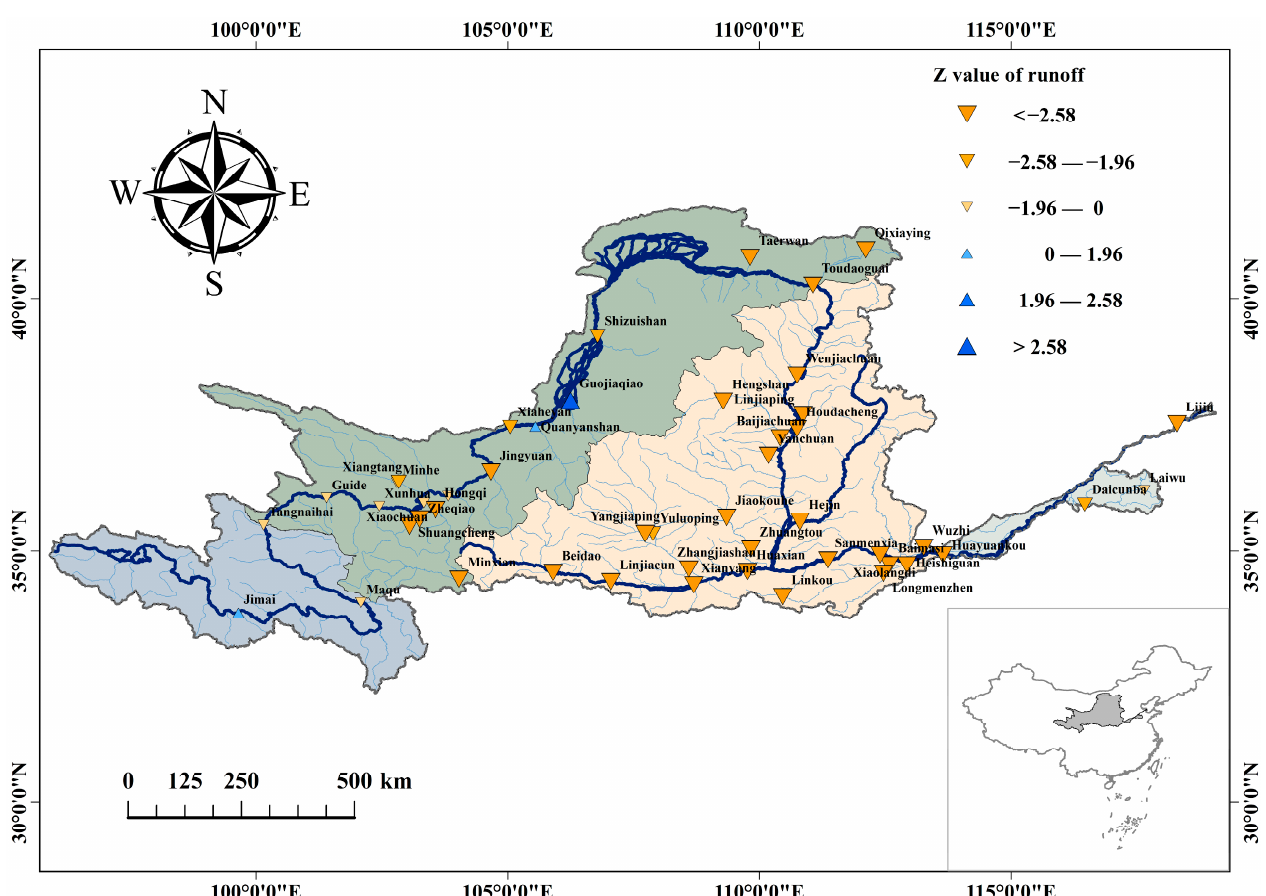
Figure 2. Interannual variation trend of runoff from the main control sections of the Yellow River Basin. The temporal and spatial changes of dry season runoff and its possible ecological influence were further analyzed considering the important impact of low flow on river ecology. Based on the natural hydrological characteristics of the Yellow River Basin, the measured runoff from December to March of the next year was selected as the runoff of the Yellow River Basin during the dry season. The results are shown in Table 3 and Figure 3. It can be seen that the runoff during the dry season in the upper reaches of the Yellow River has a significant increase, especially in the main stream sections. The eight main stream sections in the upstream, with the exception of Maqu, increased significantly in the dry season runoff. This may be caused by two aspects, one being the intensification of glacial meltwater, the other the regulatory influence of the reservoirs. However, the dry season runoff in the middle and lower reaches (below Toudaoguai) exhibited a decreasing trend, and this trend was significant in most sections. As the estuary section, the Lijin section had the highest decreasing rate of the dry season runoff among all mainstream river sections, and the Z value reached − 5.06. Obviously, this change posed a serious challenge to the water demand of the Yellow River Delta wetlands [46].